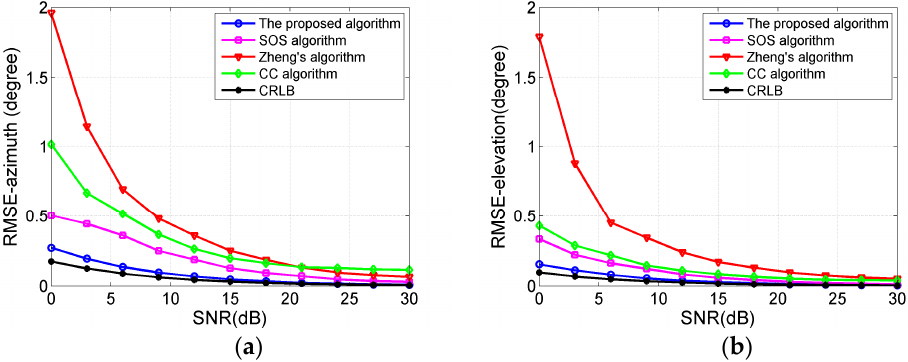
Figure 3. ( a ) RMSE curves of the central azimuth DOA estimations versus SNR; ( b ) RMSE curves of the central elevation DOA estimations versus SNR.